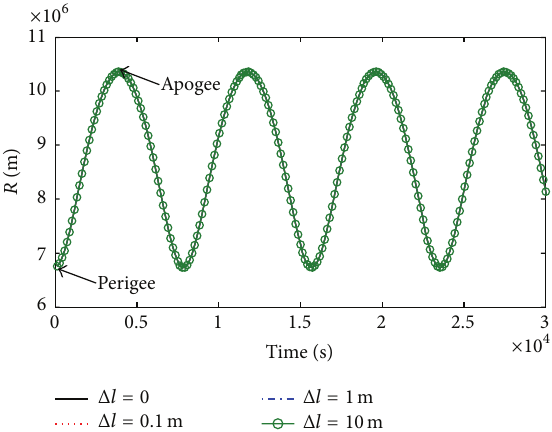
Figure 9: Time history of 𝑅 with different Δ𝑙 , 𝜏 = 250 kN ⋅ m.